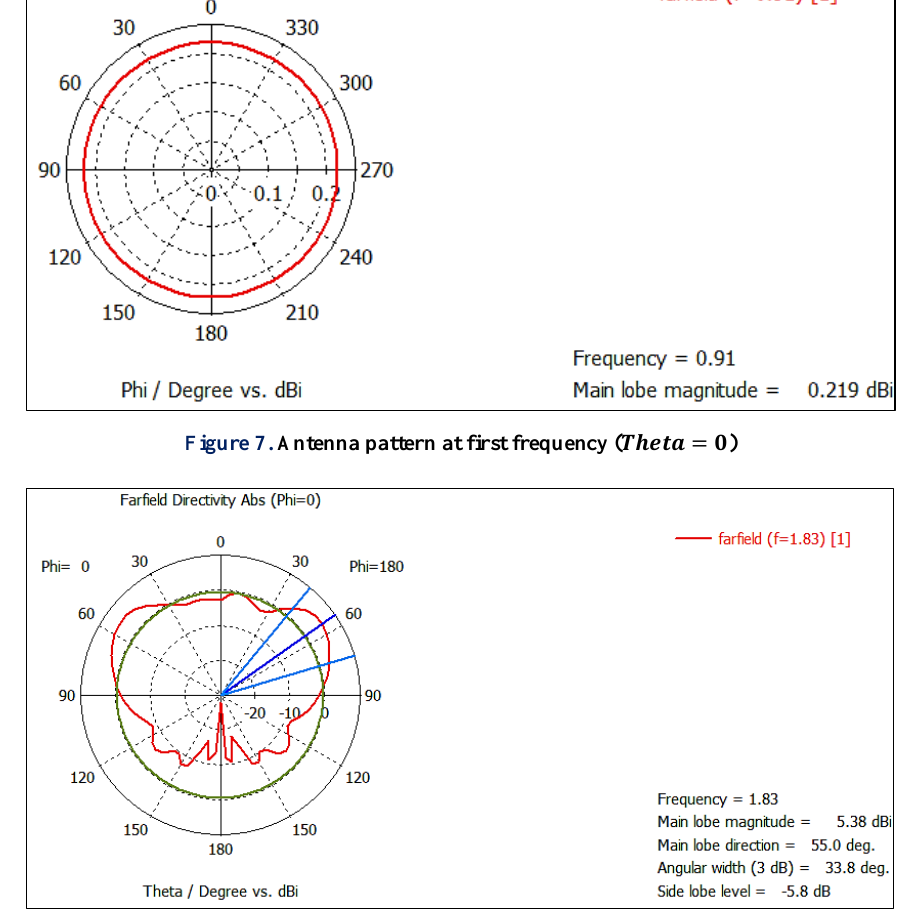
Figure 8. Antenna pattern at second frequency ( 𝑷𝒉𝒊 = 𝟎